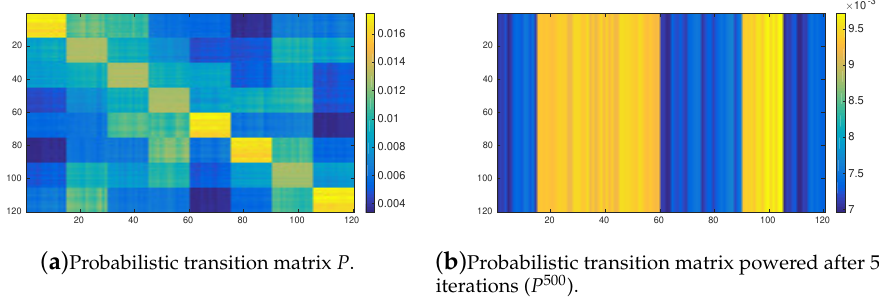
Figure 5. Probabilistic transition matrix induced by the OPRF with nTH = 2 for the 120 tasks arranged into 8 clusters.